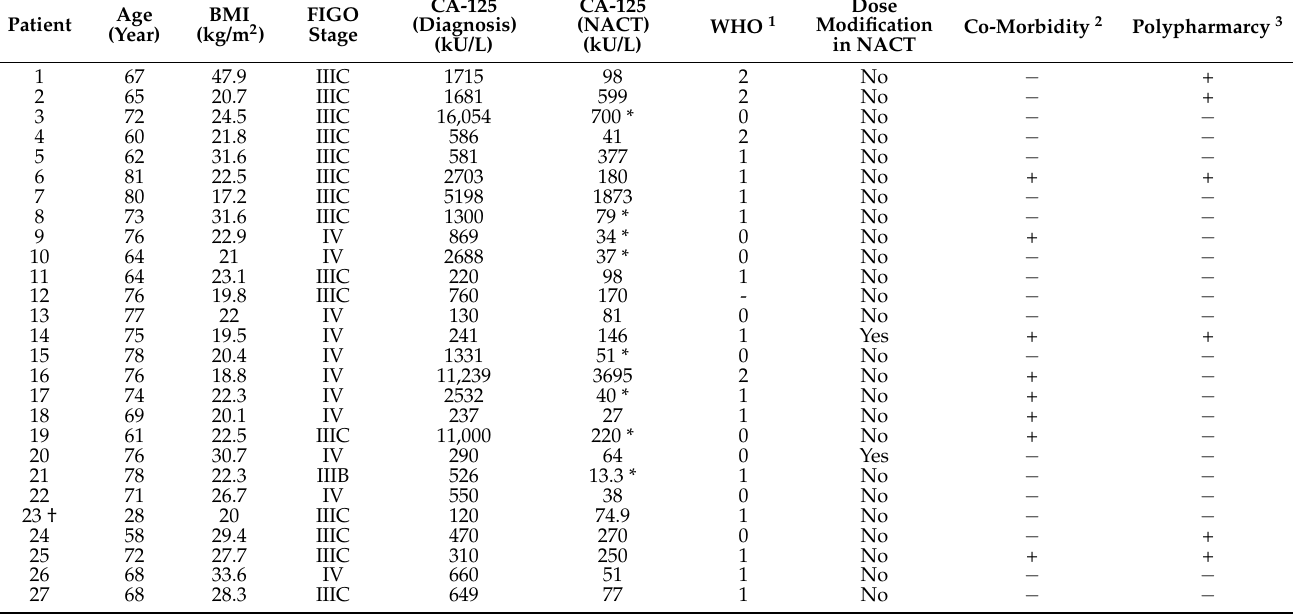
Table 1. Patient